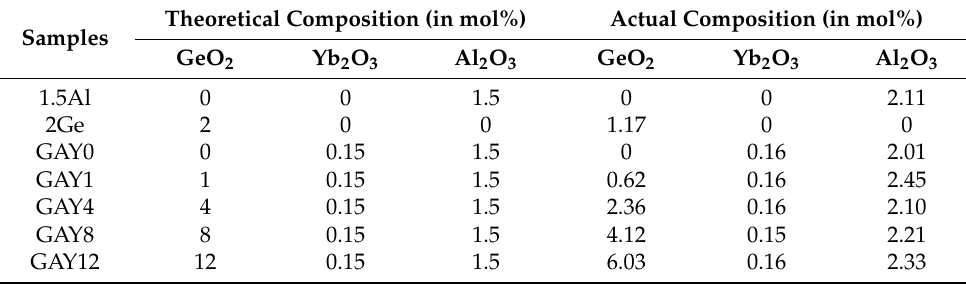
Table 1. Theoretical and actual compositions of the GAY, Al-doped, and Ge-doped samples.